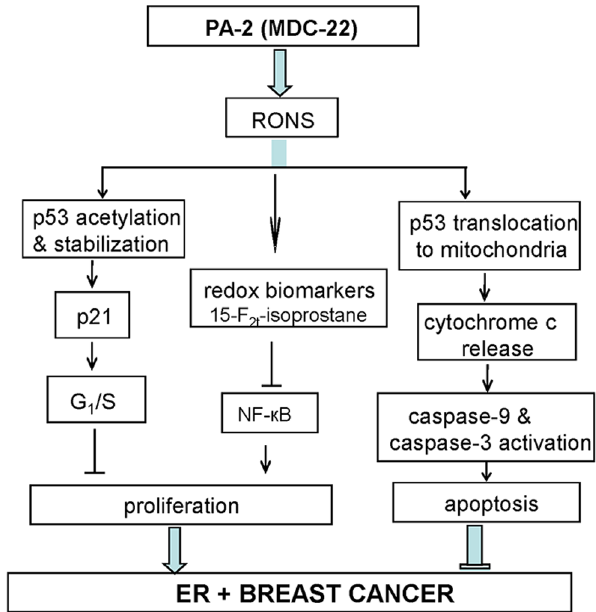
Figure 8. Proposed mechanism for the anticancer effect of phospho-aspirin-2 in ER + breast cancer. PA-2 inhibits ER + breast cancer through (i) induction of oxidative stress; (ii) acetylation of p53, which disrupts p53-MDM2 interaction and increases the expression of p21; and (iii) translocation of p53 to the mitochondria; which ultimately results in mitochondrial-dependent apoptosis and cell growth